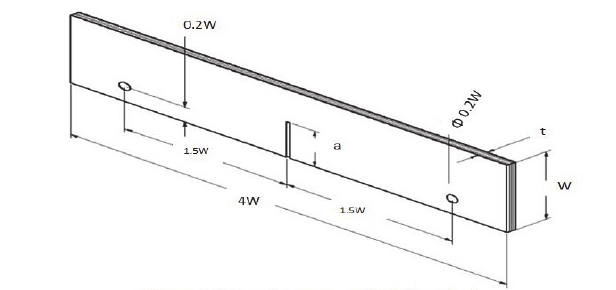
Figure 1: ENT specimen as per ASTM standard [13].